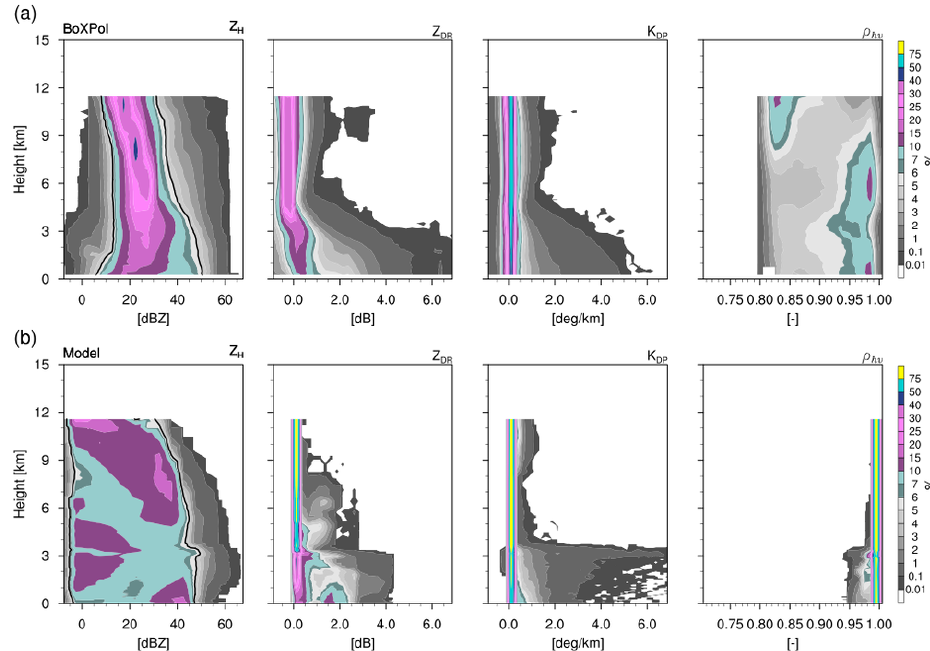
Figure 13. CFADs of horizontal reflectivity, differential reflectivity, specific differential phase and cross-correlation coefficient from 13:30 to 14:15UTC on 13 May 2016. CFADs from the model are shown for one ensemble member from 15:00 to